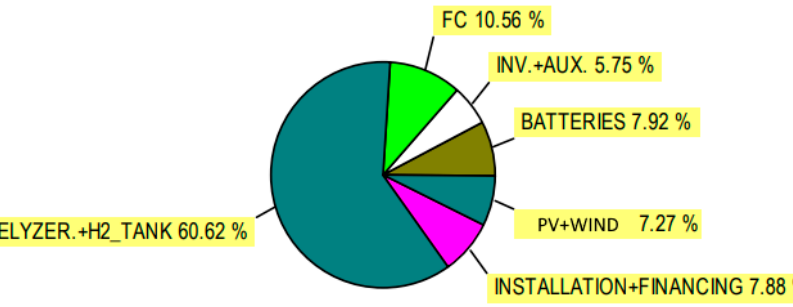
Figure 15. Analysis cost of the system for the second case using iHOGA. The results for pollutant emissions (carbon dioxide) are presented in Table 12. Table 12. Pollutant emissions for the second case using iHOGA.